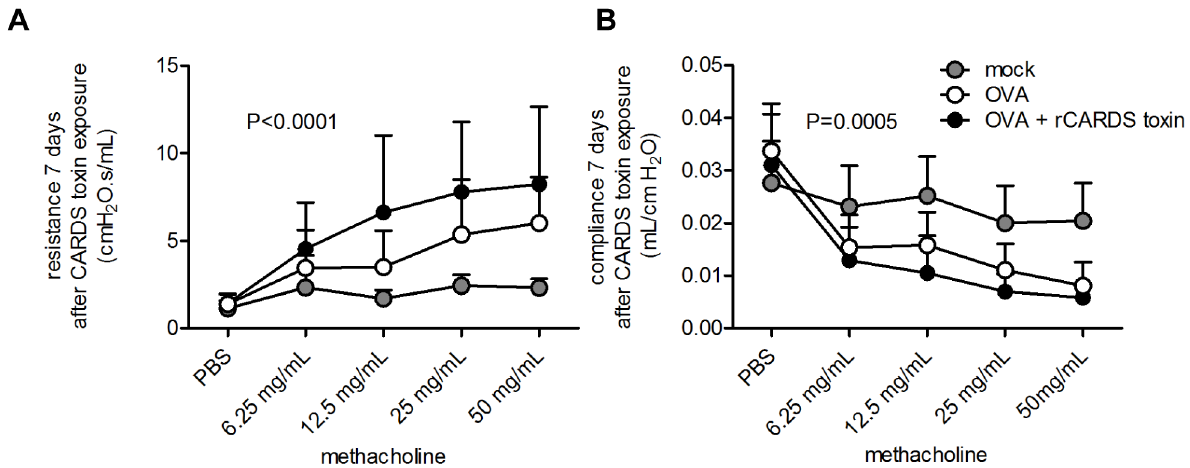
Figure 5. rCARDS toxin exacerbates OVA-induced airway hyperreactivity in BALB/cJ mice. Airway hyperreactivity was directly measured by changes in airway resistance and lung compliance through a methacholine dose curve. (A) Dynamic airway resistance (p , 0.0001) and (B) Dynamic compliance (p=0.0005) measurements were made 7 days after CARDS toxin exposure and analyzed using 2-way ANOVA.